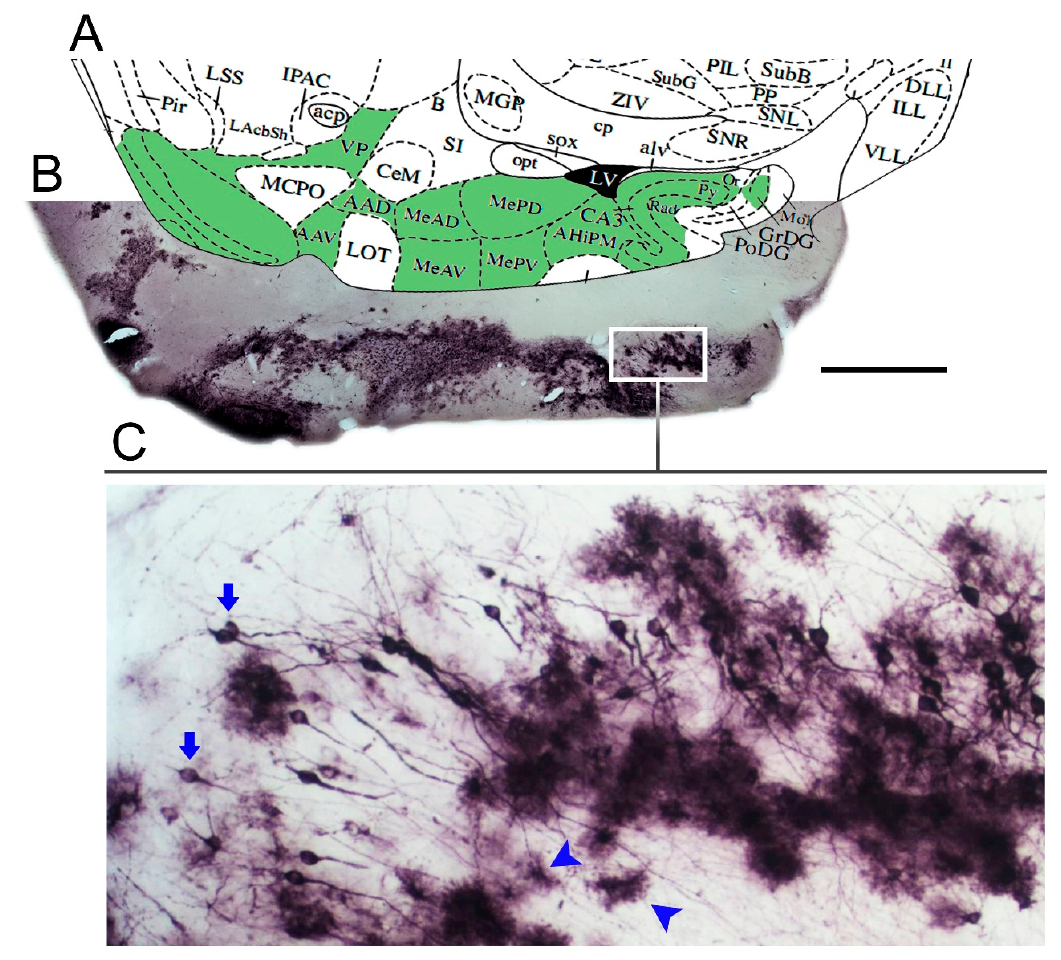
Figure 1. Low ‐ and medium ‐ power photomicrographs of a parasagittal section from the brain of a mouse infected with Piry virus, at day 8 post ‐ nasal instillation. Diagram at the corresponding level ( A ) of a mouse brain stereotaxic atlas [44] is used to identify the stained neuroanatomical areas (green areas in the diagram) with virus antigens ( B ). Immunostained neurons and glial cells are indicated by arrows and arrow heads, respectively ( C ). VP = ventral pallidum; AAD = anterior amygdaloid area; AAV = anterior amygdaloid area—ventral part; MeAD = medial amygdaloid nucleus, anterior dorsal; MeAV = medial amygdaloid nucleus, anteroventral part; MePD = medial amygdaloid nucleus, posterodorsal part; MePV = medial amygdaloid nucleus, posteroventral part; CA3 = field CA3 of hippocampus; amygdalohippocampal area; Or = oriens layer of hippocampus; Py = pyramidal cell layer of hippocampus; Rad = Stratum radiatum of the hippocampus; Mol = molecular layer of dentate gyrus; GrDG = granular layer of dentate gyrus; PoDG = Polymorph layer of the dentate gyrus.